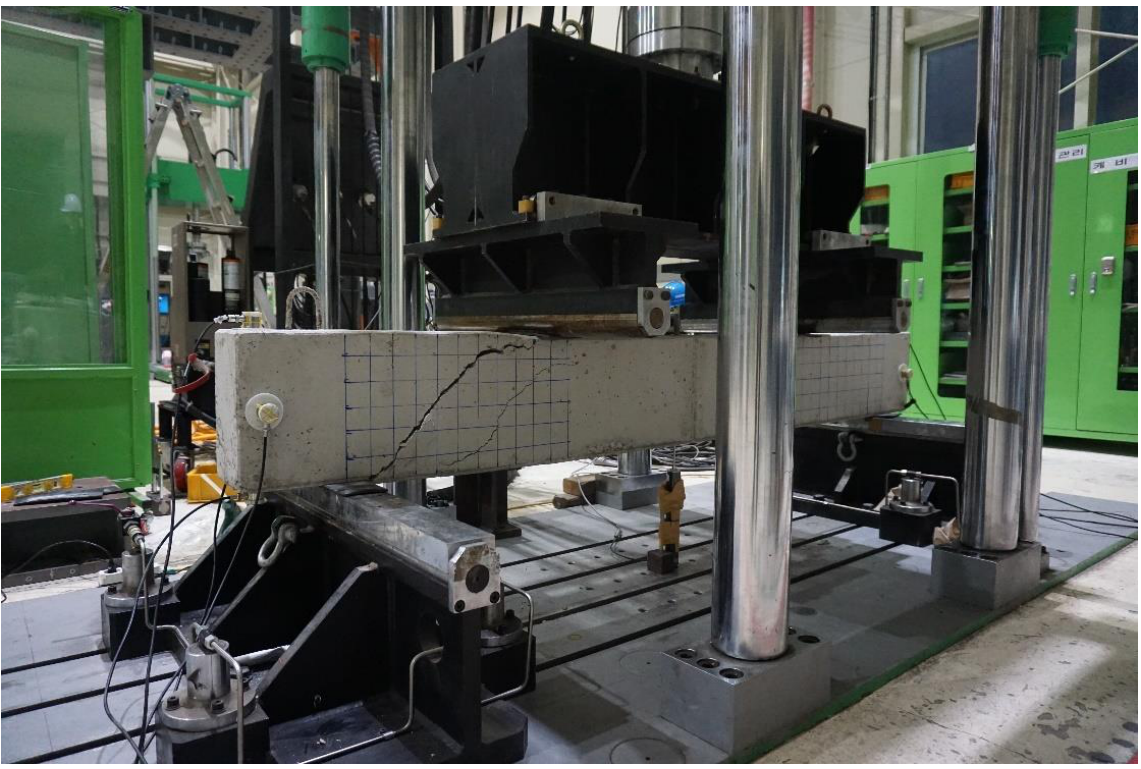
Figure 4. Damage sustained by a specimen during the test.